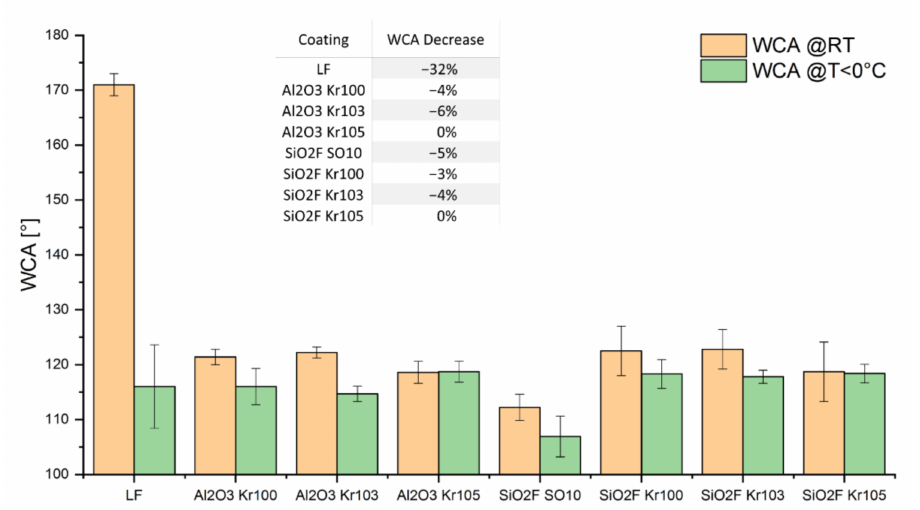
Figure 6. Static water contact angle (WCA) measurements at ambient temperature (WCA @RT in the graph legend) and the average values of WCA detected on the different coated samples in the temperature range between − 2.5 and − 10 ◦ C (WCA @T < 0 ◦ C in the graph legend). The table produced as inset reports the percentage decrease of WCA between RT and T < 0 ◦